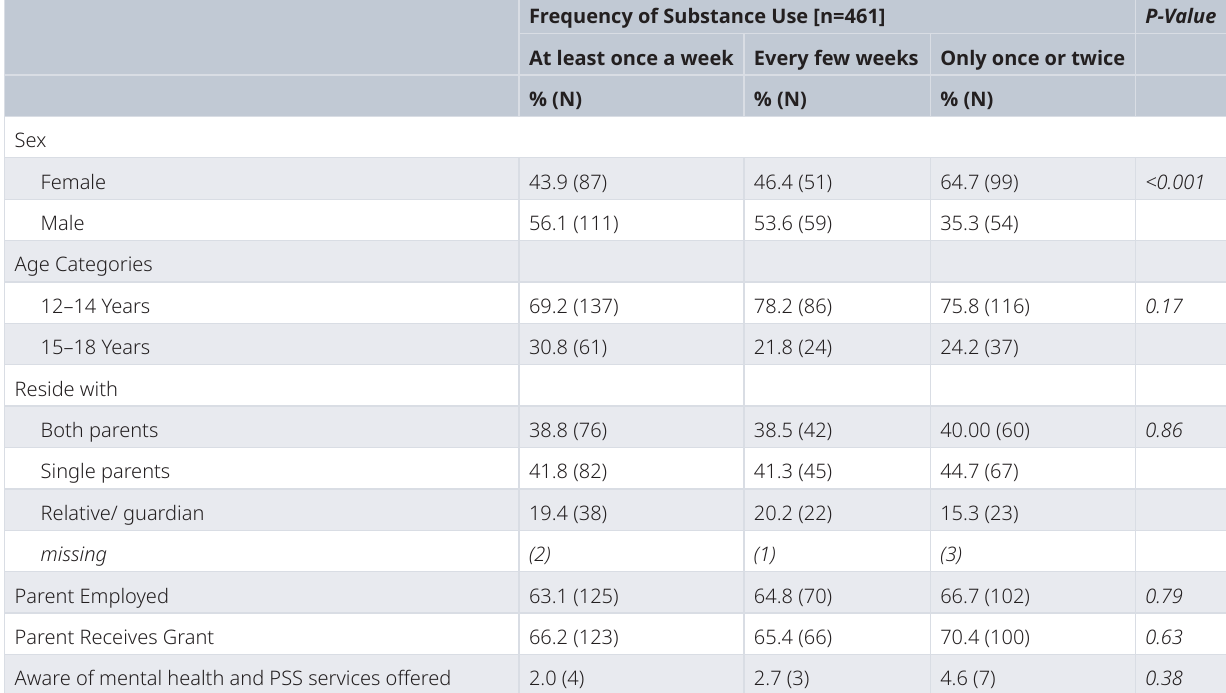
Table 6. Demographic and social support variables of current substance users by frequency of substance use.